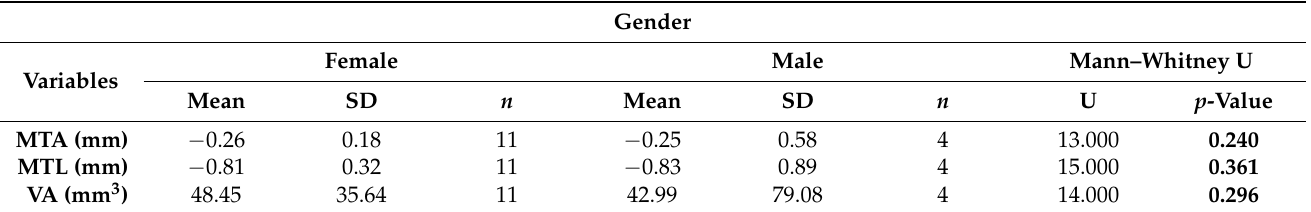
Table 2. Age comparative analysis after three months. Table 3. Gender comparative analysis after three